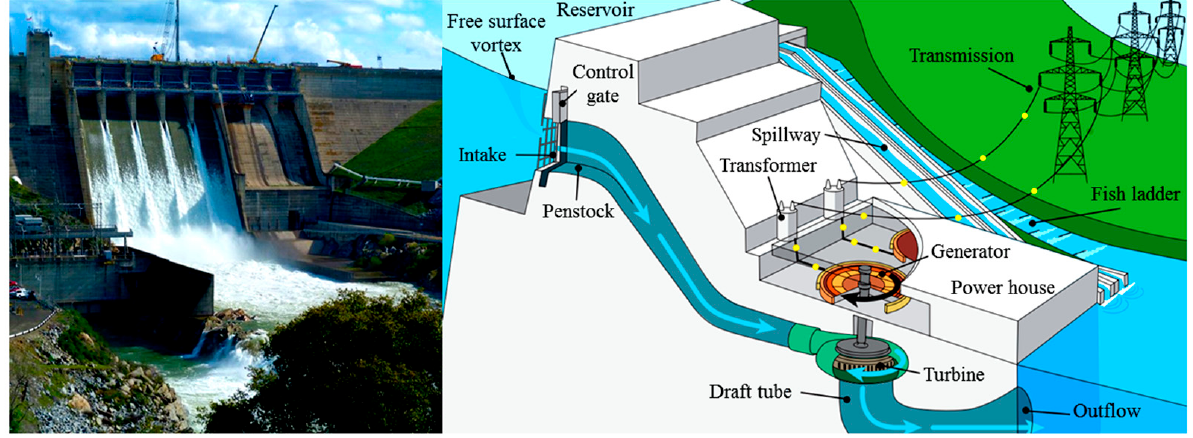
Figure 1. Gravitational surface vortex generated at the hydropower station [5].